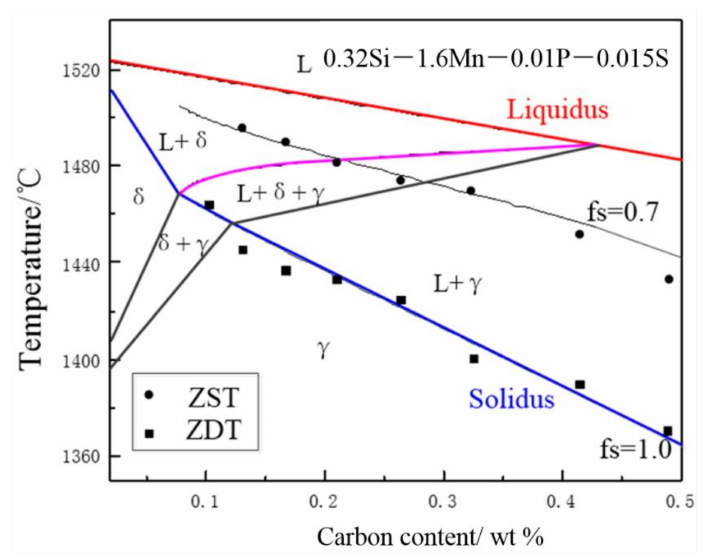
Figure 3. Nonequilibrium, pseudo binary Fe–C phase diagram of the Fe–C–0.32Si–1.6Mn–0.01P– 0.015S